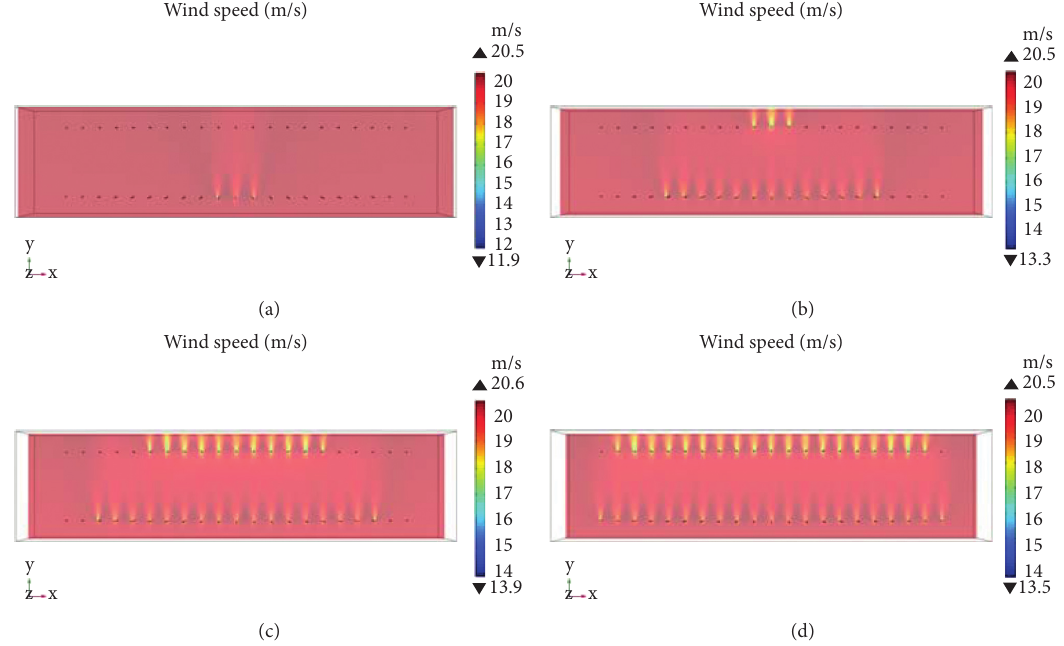
Figure 9: Influence of height for wind field (wind direction � 90 ° ). (a) 90 ° , z � 10m. (b) 90 ° , z � 5m. (c) 90 ° , z � 3m. (d) 90 ° , z � 1